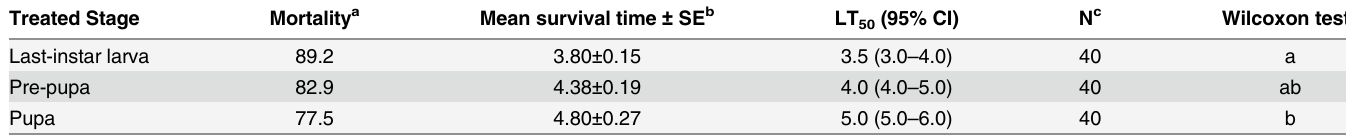
Table 1. Corrected mortality (%), mean survival time and LT 50 (days) of L . decemlineata immature stages treated by suspensions of 5×10 7 blasto- spores/ml of I . fumosorosea CCM 8367.